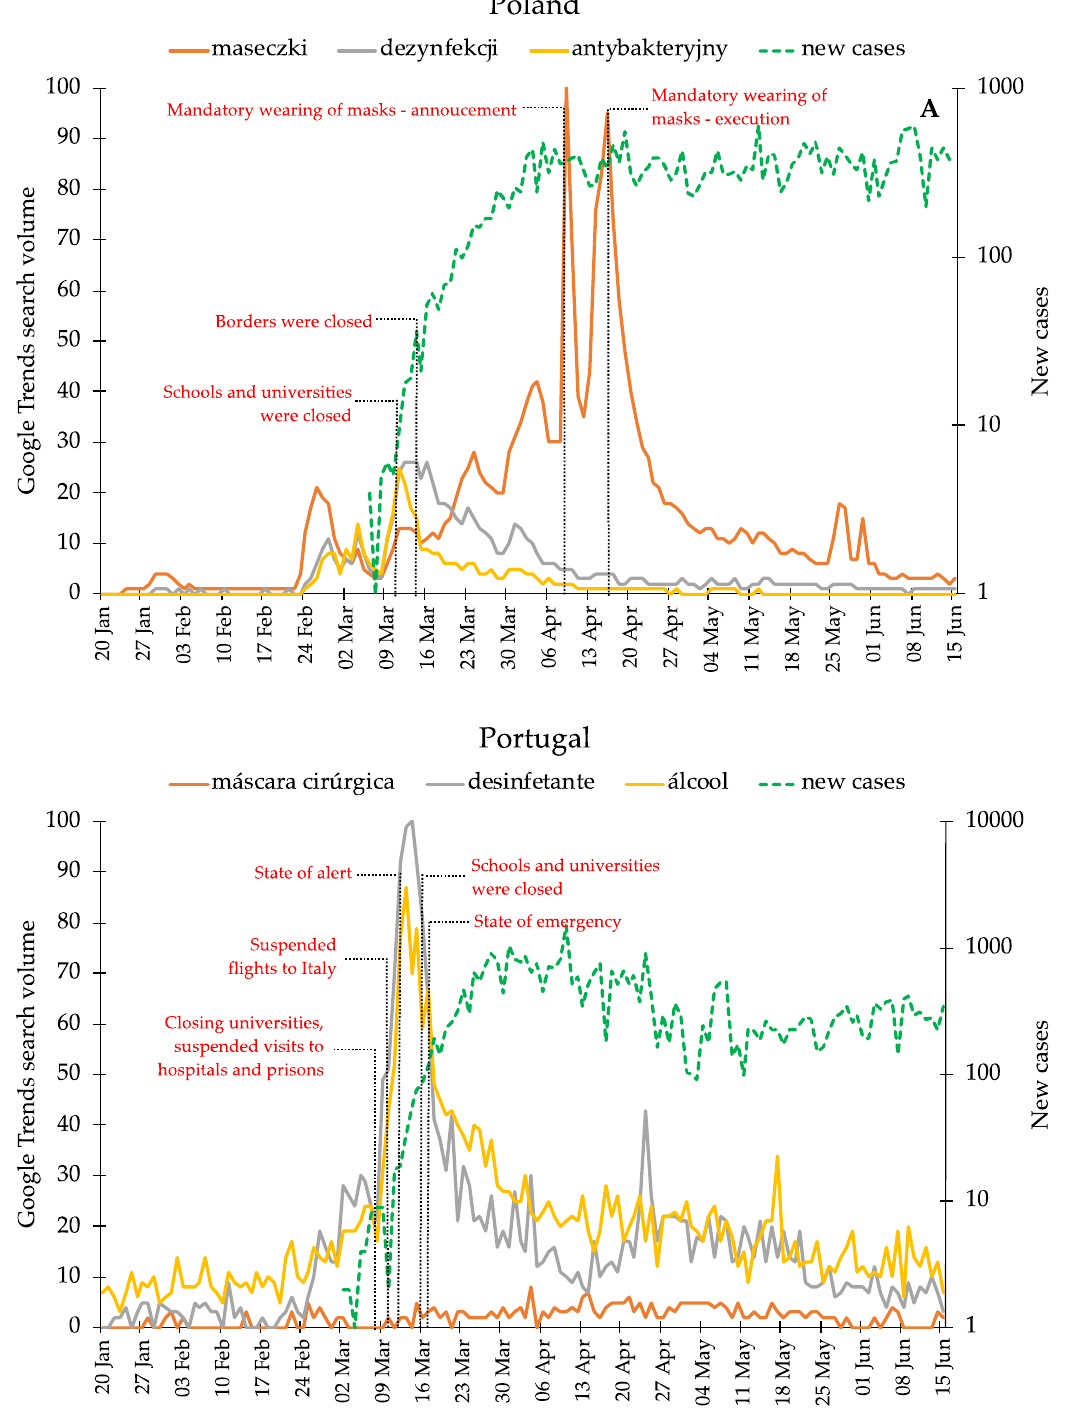
Figure 1. Evolution of the keywords in GT in Poland and in Portugal from 20 January to 15 June compared to the number of new cases in each country respectively.